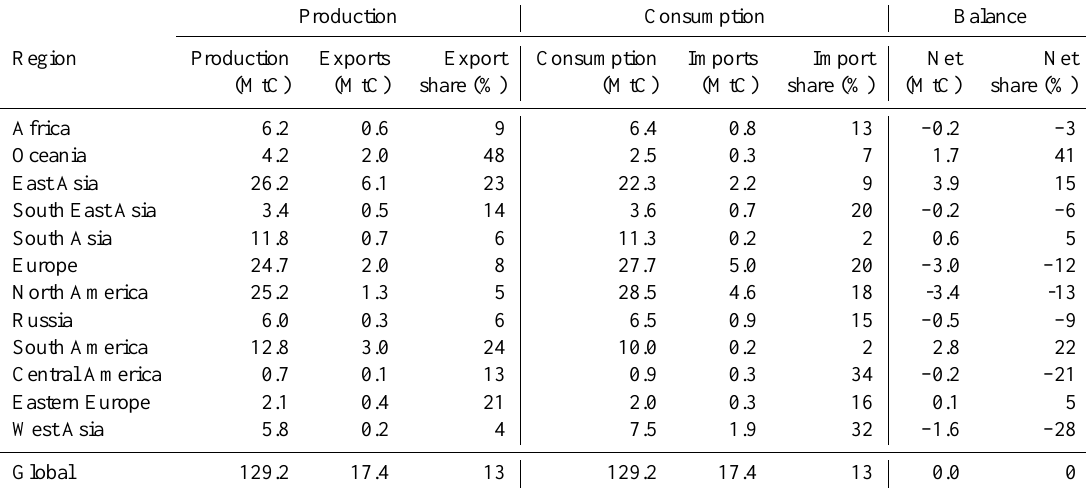
Table 12. The 2004 carbon in livestock products in each region (production), the amount and share exported, the consumption amount and share imported, and the difference between production and consumption (and exports and imports). Exports and imports only represent the trade between the RECCAP regions, and do not include the trade between countries within a region (e.g. Finland and Sweden). The shares are always in terms of production.